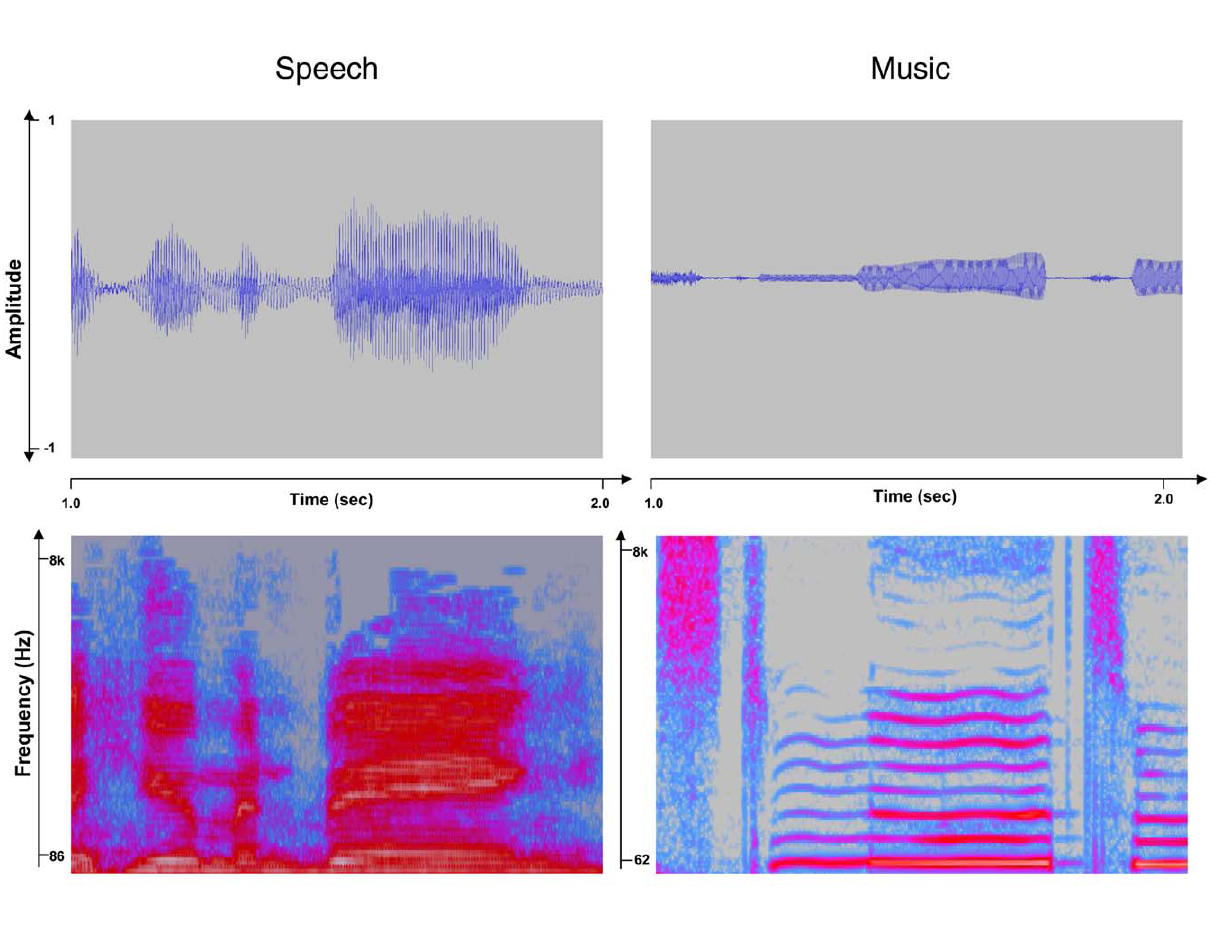
Figure 1. Acoustical representations of speech and song. The top panels show the waveforms (amplitude as a function of time) of 2-s excerpts of samples of spoken and sung speech, respectively. The bottom panels show spectrograms (frequency as a function of time) of the same sound samples; intensity is coded by a color scale in this representation. Note the prominent fundamental frequency and harmonics (horizontal lines) present in the sung speech.